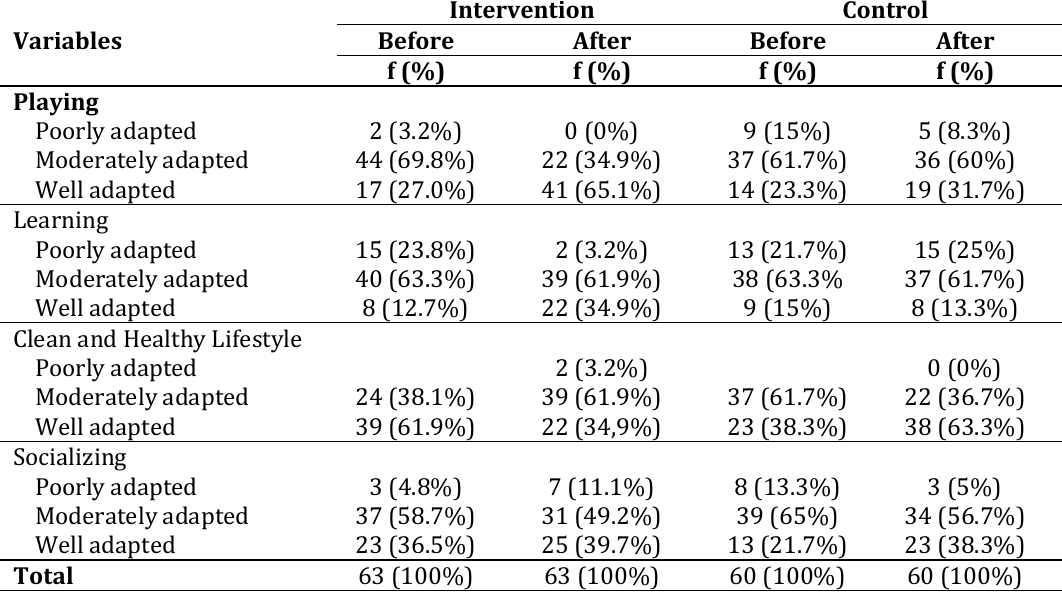
The Distribution of Level of Adaptation Toward Playing, Learning, Clean and Healthy Lifestyle, and Socializing Activities among Children Before and After the Intervention